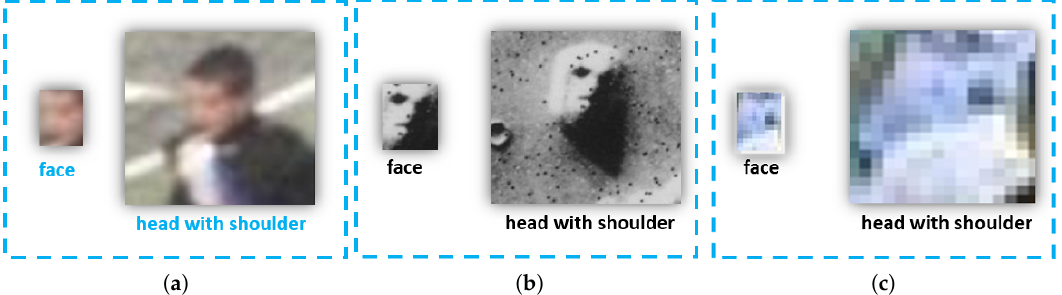
Figure 1. Examples of the “head with shoulder” information helping face detection. ( a ) The existence of the “head with shoulder” region can increase the confidence of detecting a face. ( b ) A region that looks like a face turns out to be a crater when we see its “head with shoulder” region. ( c ) An example of an area mistakenly detected as a face by the multi-task cascaded convolutional network (MTCNN), but rejected by the head-shoulder